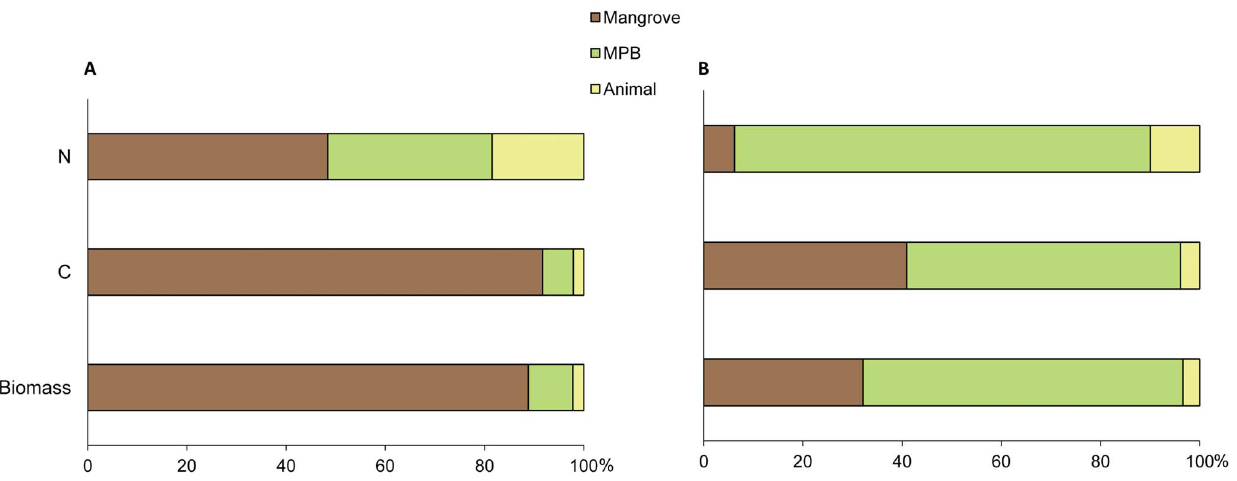
Figure 4. Estimation of the diet composition of P.erythodactyla by the IsoConc mixing model. Percentage contribution of the mangrove leaf, MPB and animal food sources in the crab’s diet were estimated by the IsoConc mixing model using (A) our determined isotopic discrimination values (Table 1) and (B) the global means of trophic discrimination values for aquatic food web of 0.5 % for C and 2.9 % for N [39].